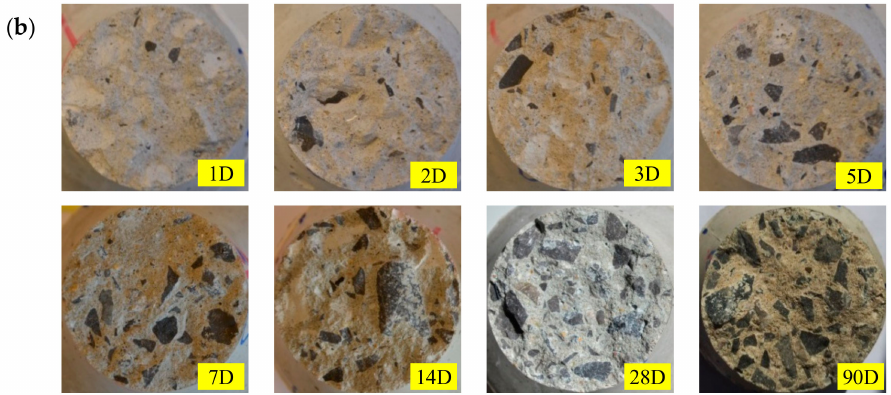
Figure 6. Fracture surface of specimens tested at increasing ages, ( a ) for specimen type 6.3; ( b ) for specimen type 16.